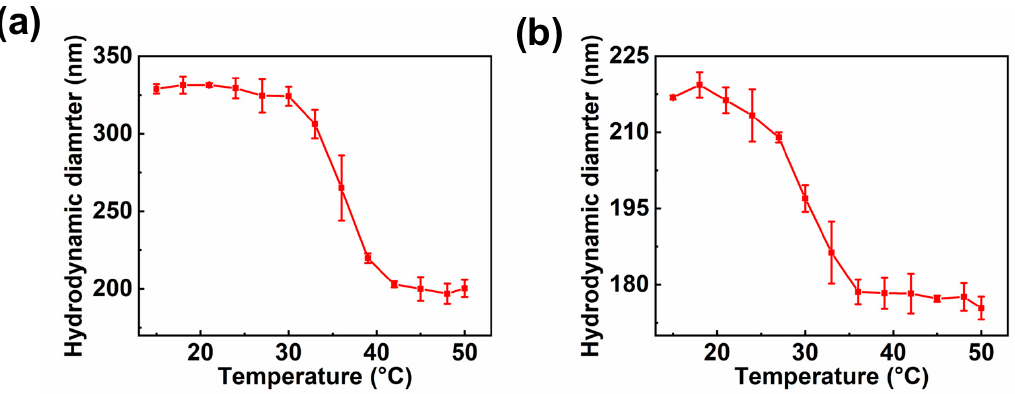
Figure 7. Diameter of ( a ) PSV@PSS-b-PNIPA@Ag and ( b ) PSV@PNIPA-b-PSS@Ag with temperature.